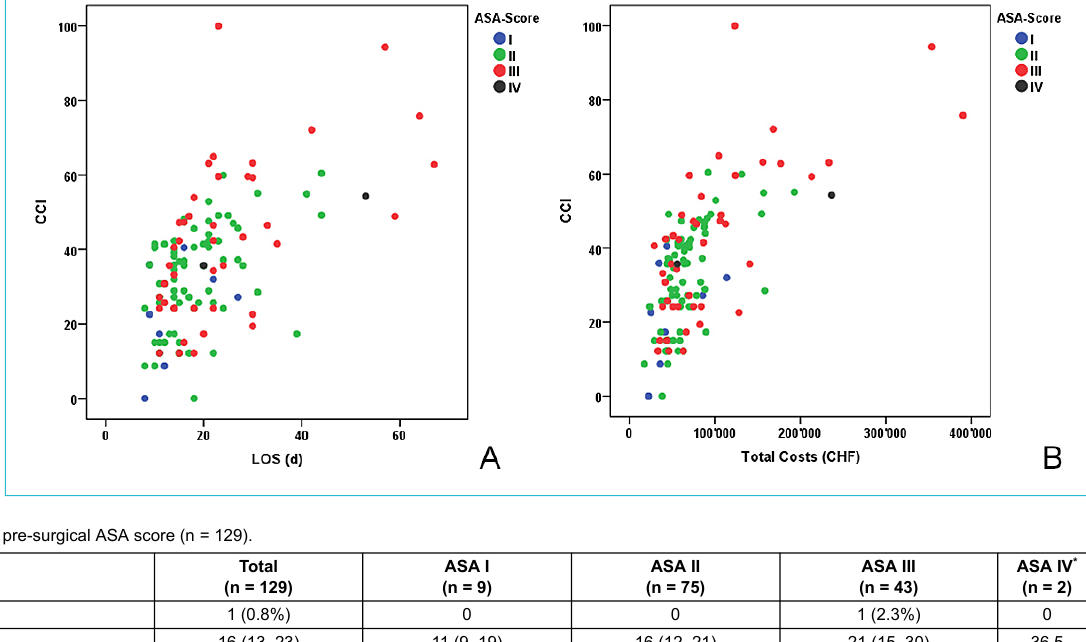
Figure 1: Scatter plots of comprehensive complication index (CCI) in points and length of stay (LOS) in days (above) as well as in-patient treatment costs in CHF (below) per patient. Color-coding indicates pre-surgical morbidity as defined by the American Society of Anesthesiolo- gists (ASA) score; n = 129.